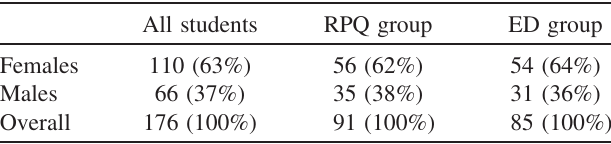
TABLE III. Gender information for groups surveyed. All